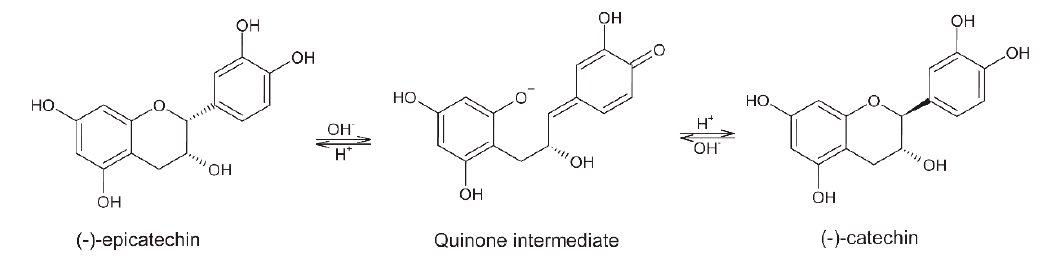
Figure 6. Epimerization of ( − )-epicatechin to ( − )-catechin.